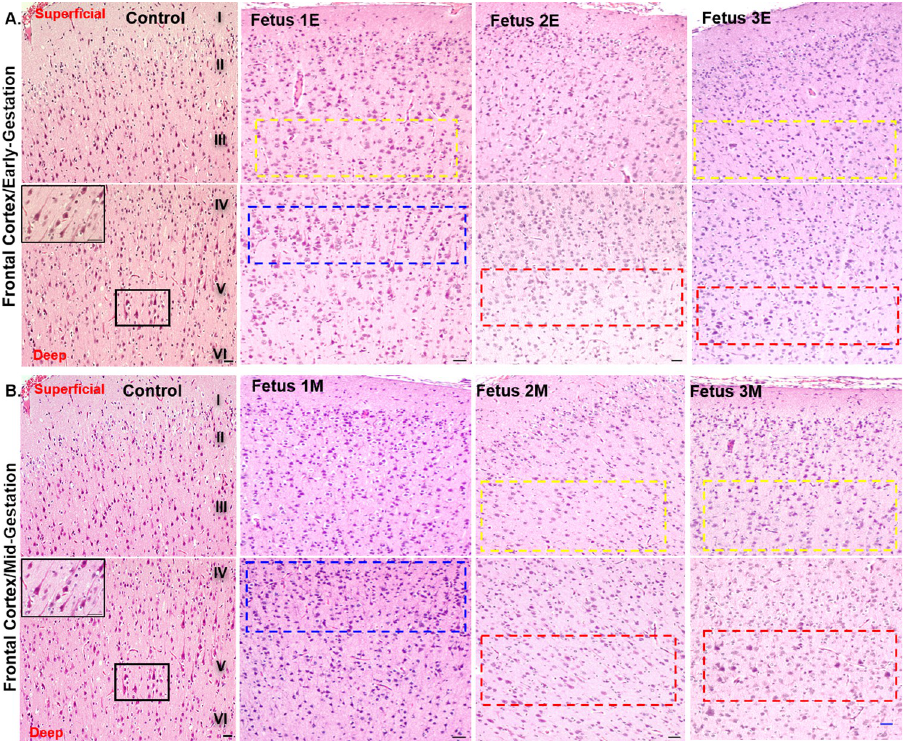
Fig 5. ZIKV inoculation disrupts formation of six-layered cortex in a developing fetal brain. Representative images from H&E staining of control and early-gestation ( A ) and mid-gestation ( B ) cortical plate of the fetal frontal cortex. The histological stain shows control fetal brain with orderly formation of six layers of cortex compared to the disturbance of this process in the fetal cortical plates from fetuses from early ( A ) and mid-gestation ( B ) inoculated dams. Yellow dotted areas highlight lack of small pyramidal neurons in Layer III. The blue dotted areas highlight presence of small pyramidal neurons normally present in Layer III seen instead shifted down to Layer IV which normally consists mostly of stellate cells and smaller portion of pyramidal cells. The red dotted areas highlight lack of large pyramidal neurons in Layer V of the cortical plate as seen in the control image (box and inset). In Fetus 3E and 3M, some of the cells highlighted in the red dotted areas could be cells other than the large pyramidal cells typical of Layer V since these cells appear lacking the characteristic apical dendrites emerging from the soma of the pyramidal neurons as seen in the control brain (inset). (Scale bar = 100 μ